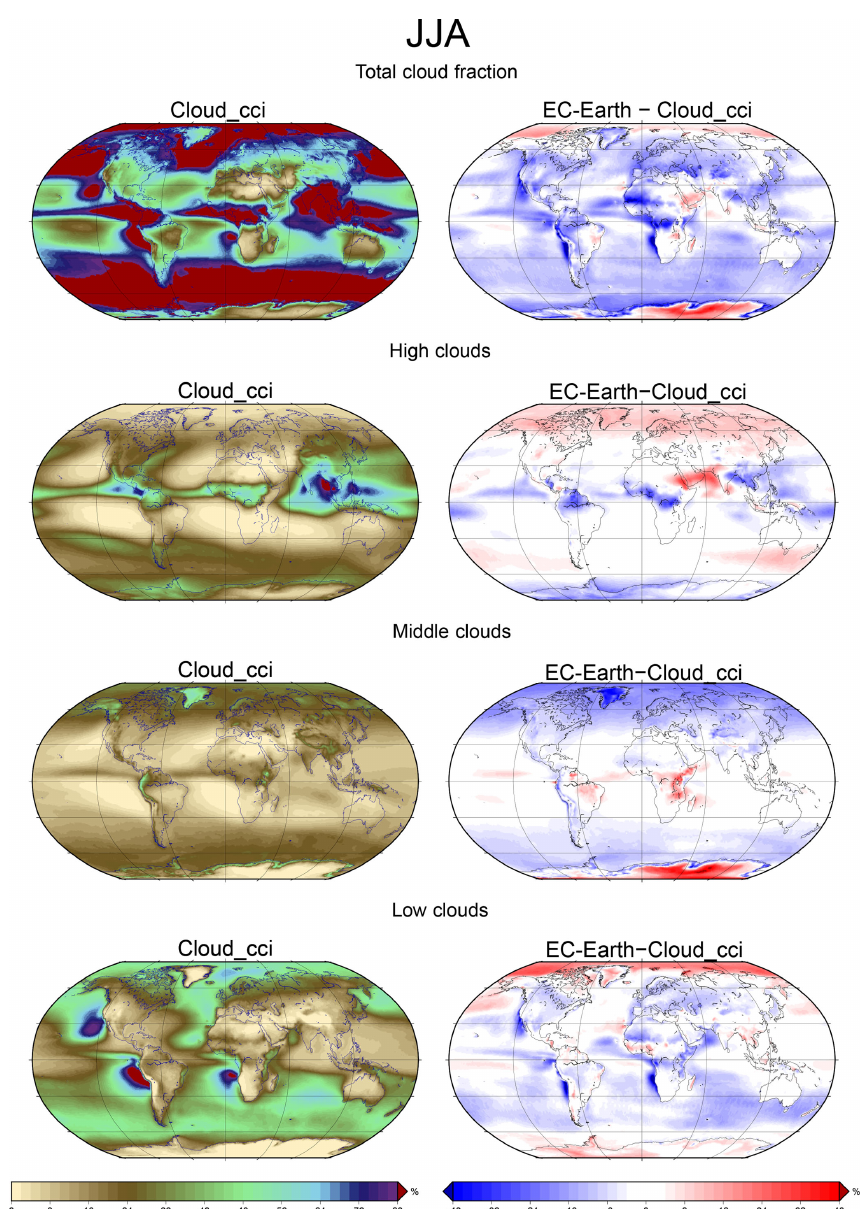
Figure 4. Cloud fractions separated by cloud altitude from the Cloud_cci CDR (left column) and difference between the simulated Cloud_cci- based EC-Earth atmosphere and the observations (right column), separated into TCF (top row), high clouds (second row), mid-level clouds (third row), and low clouds (bottom row), for